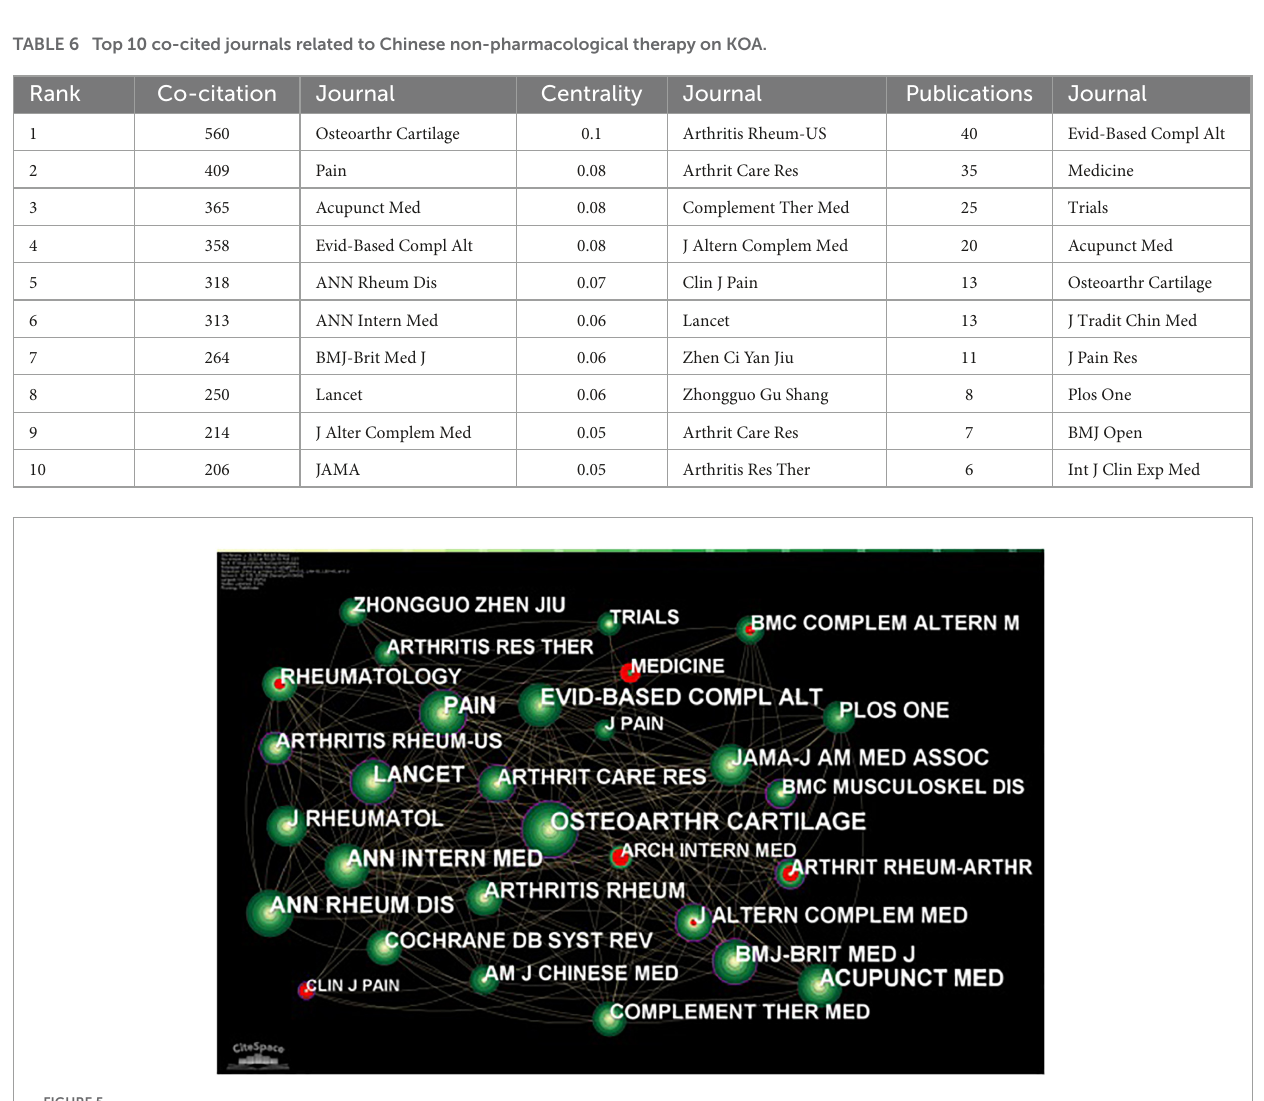
FIGURE5 The co-cited journal related to traditional Chinese non-pharmacological therapies on knee osteoarthritis (KOA).